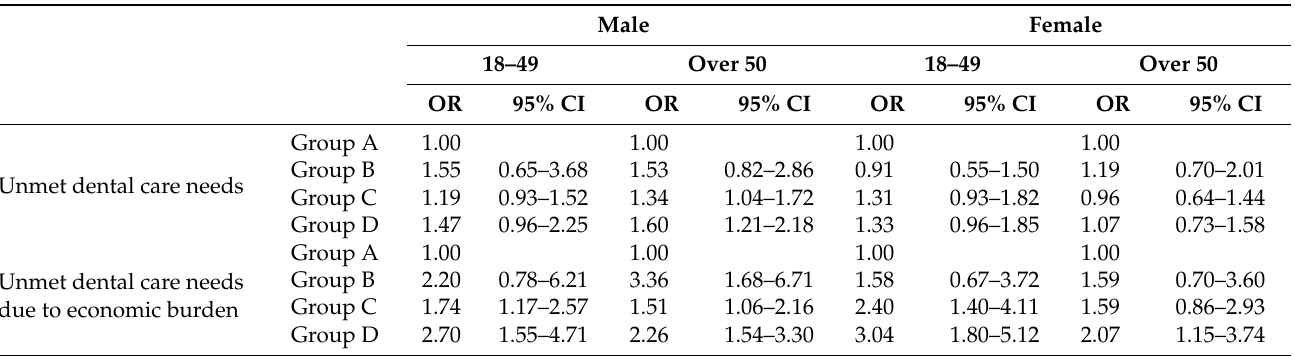
Table 4. The unmet dental care needs by precarious employment on among Korean workers from the Korea Health Panel Survey (2011–2017) †